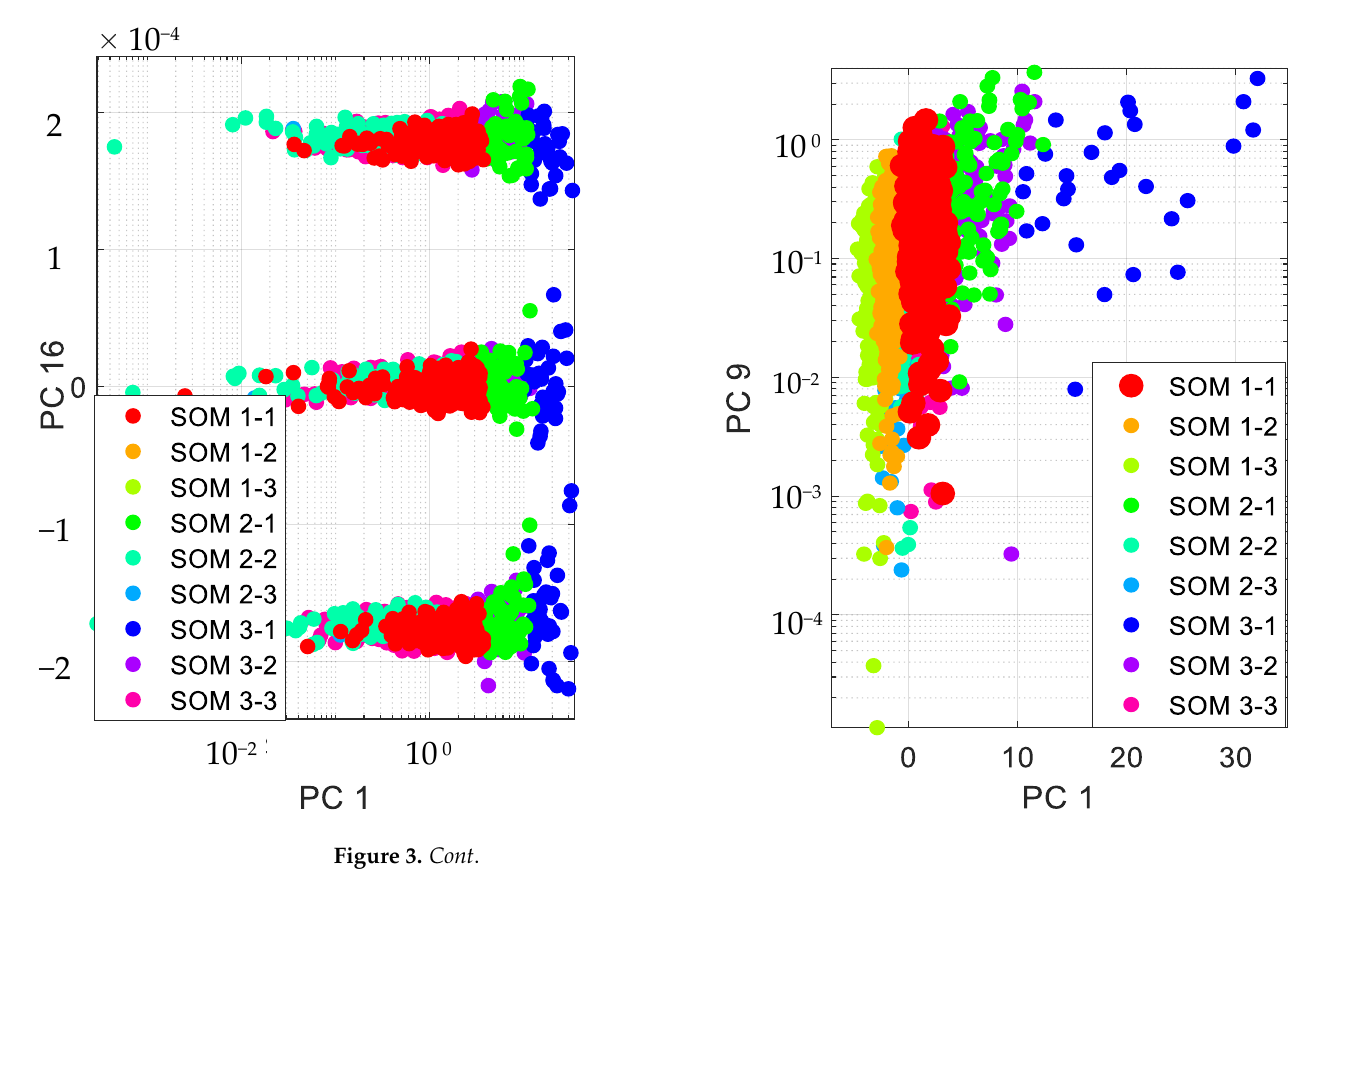
Figure 2. The results for silhouette index.